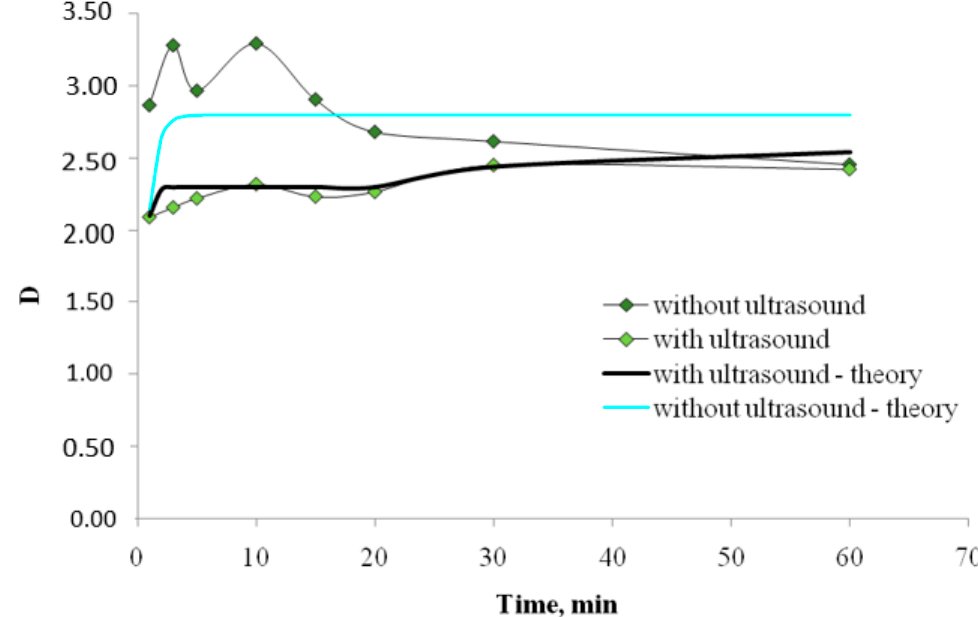
Figure 3. The time dependence of extracted Fe 3+ ions concentration in the system of polypropylene glycol 425-NaCl-H 2 O under the US exposure (US radiation with the power of 50 W and frequency of 35 kHz), and without ultrasound.